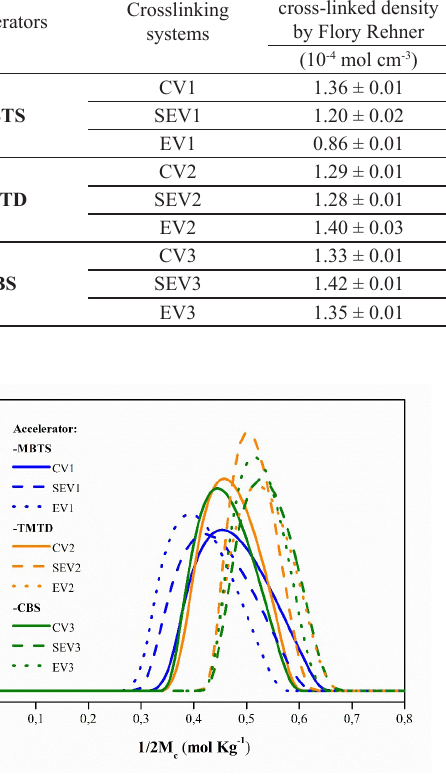
Figure 7. Distribution curves of the average molecular weight of the NR compounds vulcanized and accelerated by: MBTS, TMTD and CBS in their respective crosslinking